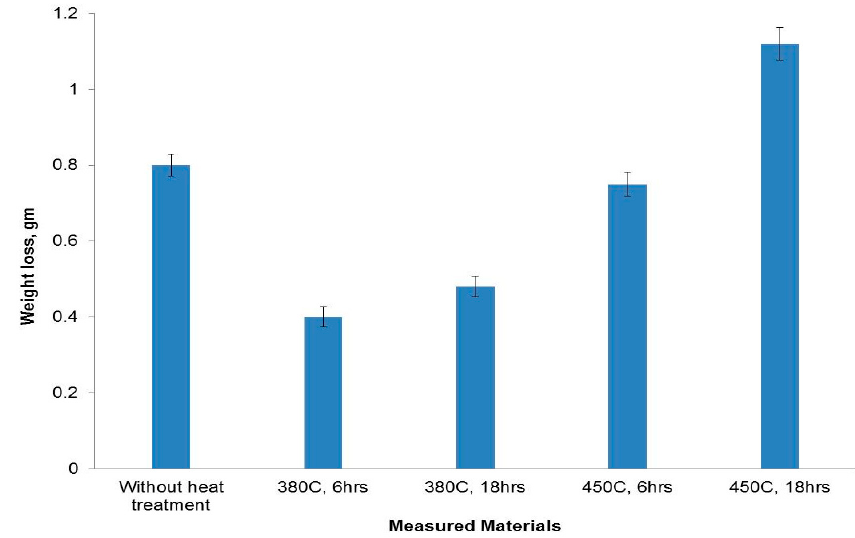
Figure 14. Wear loss values of the formed composites of 6% Cu together with samples heat treated at different temperatures and times.